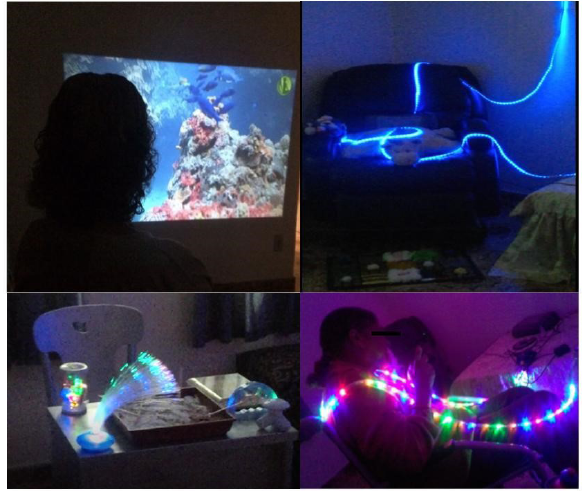
Figure 4. The lights room had optical fiber light, LED lights on the roof, overhead projector, aroma diffuser, and ambient